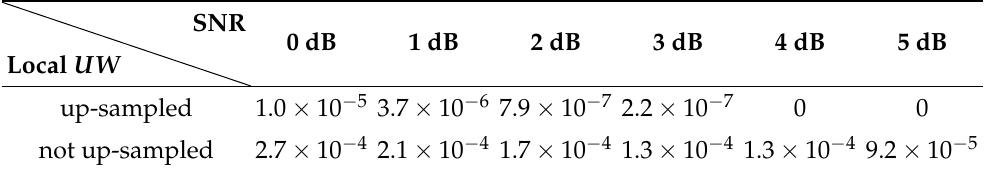
Table 3. Comparison of the false alarm rate between the local Unique Word ( UW ) being up-sampled and not being up-sampled.